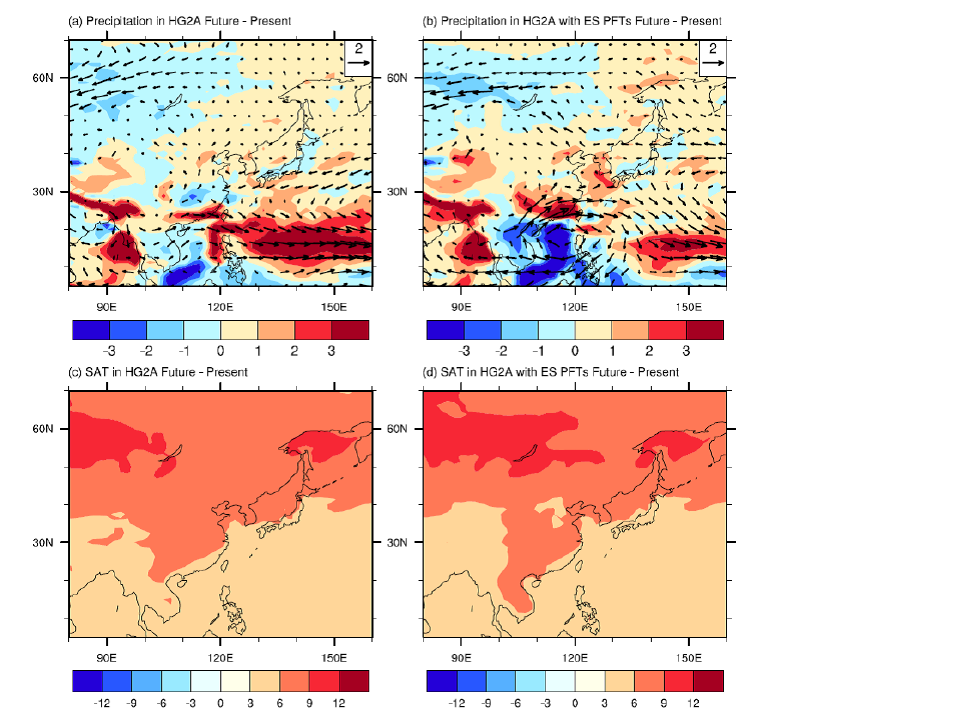
Figure 9. Changes in JJA mean precipitation (shading, mmday − 1 ) between the future time slice and the present-day HadGEM2-A experi- ments, without (a, c) and with (b, d) land cover from HadGEM2-ES. (a) , (c) is (Ats − A) and (b) , (d) is (AEts − AE).